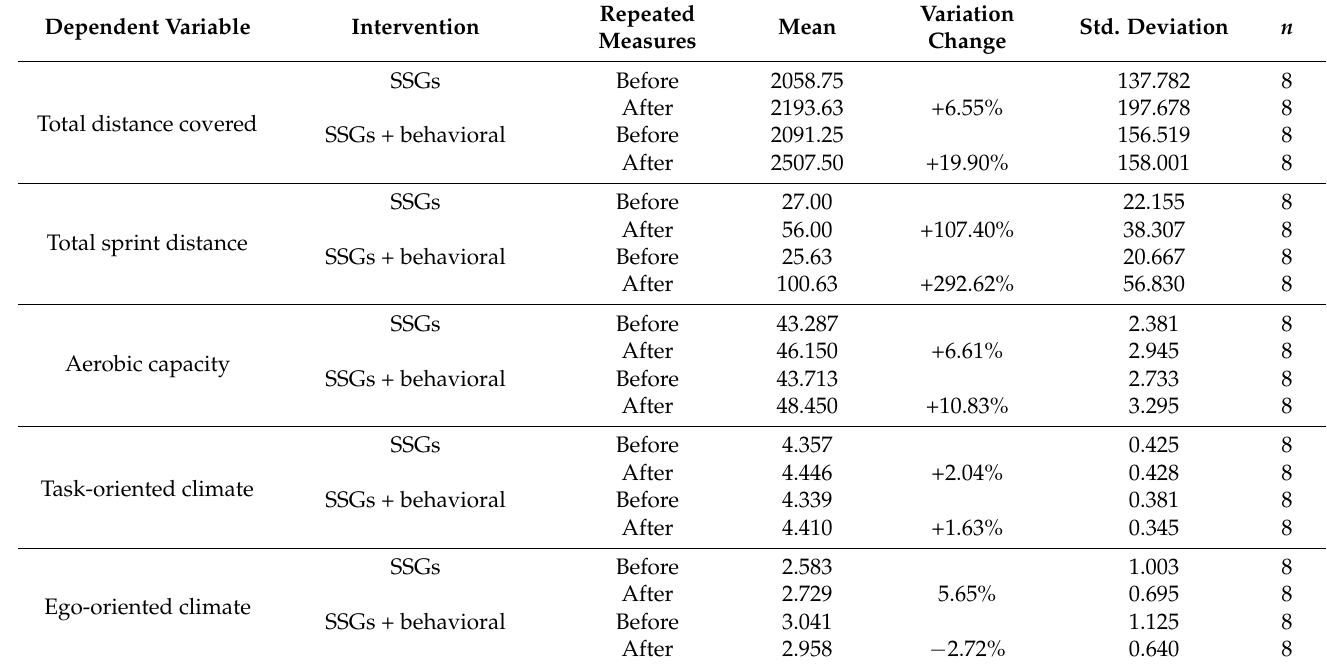
Table 2. Descriptive statistics of study participants.